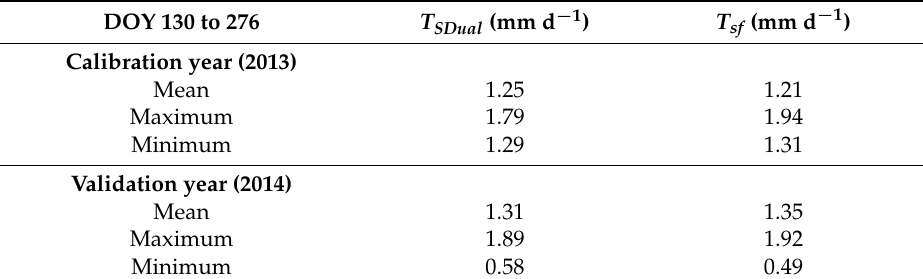
Table 4. Mean, maximum, and minimum values of predicted ( T SDual ) and observed ( T sf ) olive orchard transpiration rates for calibration (2013) and validation years